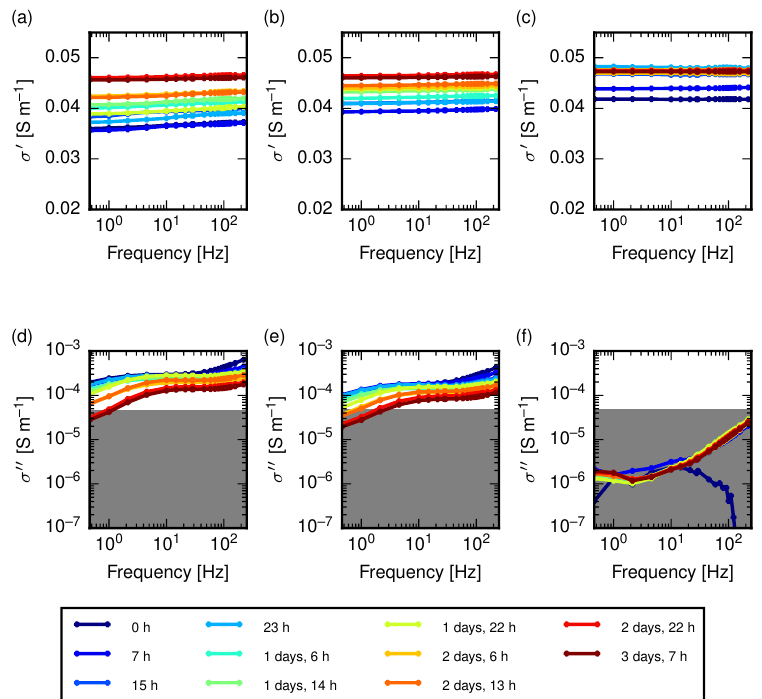
Figure 7. Intrinsic complex conductivity spectra (in terms of real component σ (cid:48) and imaginary component σ (cid:48)(cid:48) ) for all time steps (indicated by color of the curves) recovered from the multi-frequency inversion results at different locations in the rhizotron: (a, d) stem area ( x position: 20.25cm; z position: − 0.75cm); (b, e) bottom of the root system ( x position: 20.25cm; z position − 6.25cm); (c, f) water-only location ( x position: 20.25cm; z position: − 50.25cm). Positions for (a and d) and (b and e) are also indicated in Fig. 4a. Values of σ (cid:48)(cid:48) that lie below the measurement accuracy of the system (1mrad phase shift at 1kHz for water; see Zimmermann et al., 2008) are indicated by gray areas.